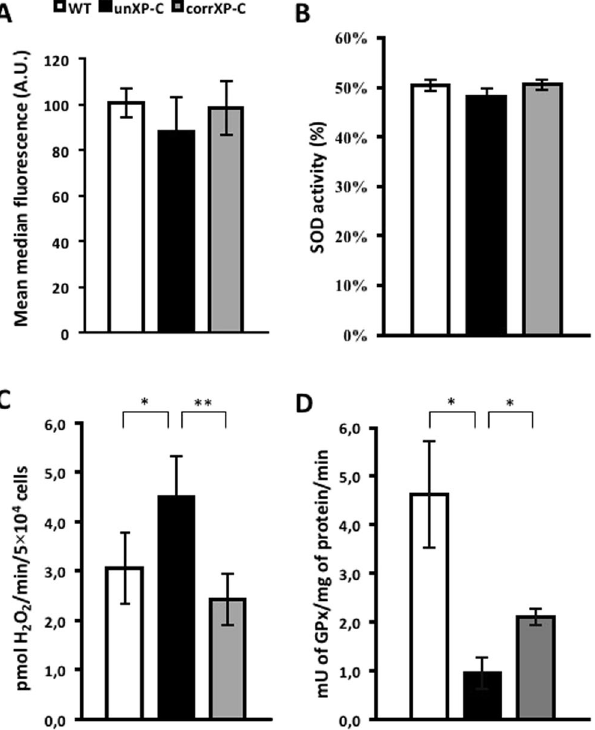
Figure 4. Redox imbalance in XP-C cells due to mitochondrial ROS production. ( A ) Superoxide generation was measured by flow cytometry using 1 × 10 5 cells incubated with 5 µ M Antimycin A, 5 µ M DPI and 5 µ M MitoSOX ® . ( B ) H 2 O 2 production was followed spectrofluorometrically with 5 µ M Amplex UltraRed ® , in presence of 5 µ M Antimycin A, 5 µ M DPI. Rate of H 2 O 2 production calculated after calibration performed with known H 2 O 2 concentrations. ( C ) SOD activity was measured using the Abcam kit, following the manufacturer’s instructions. ( D ) GPx activity was measured using 100 µ g of total cellular protein. Oxidation of NADPH to NADP + was monitored at 340 nm on a temperature-controlled spectrophotometer, at 25 °C. The results presented are the mean ± SD of n = 3 for superoxide production, n = 4 for H 2 O 2 production, n = 3 for SOD and n = 3 for GPx activity. * p < 0.05 and ** p <